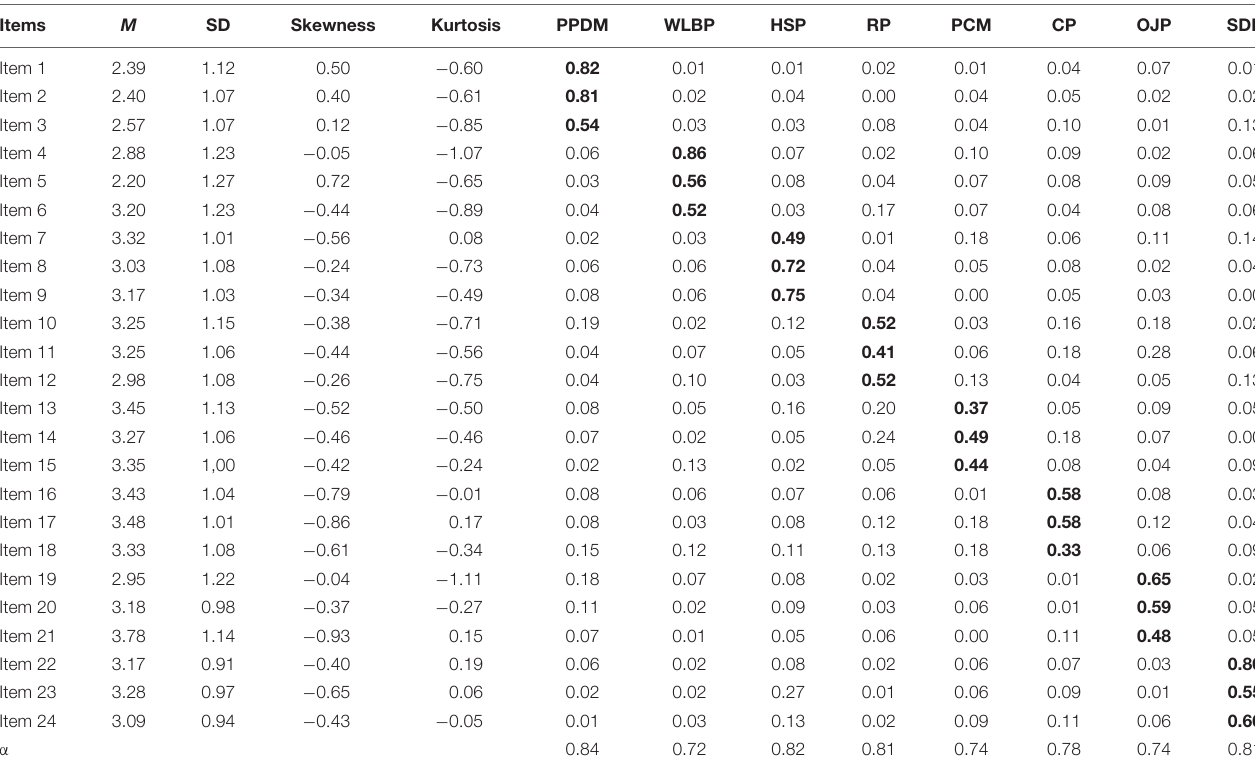
TABLE 1 | Means, standard deviations, and factor loadings of the exploratory factor analysis (Study 2). Items M SD Skewness Kurtosis